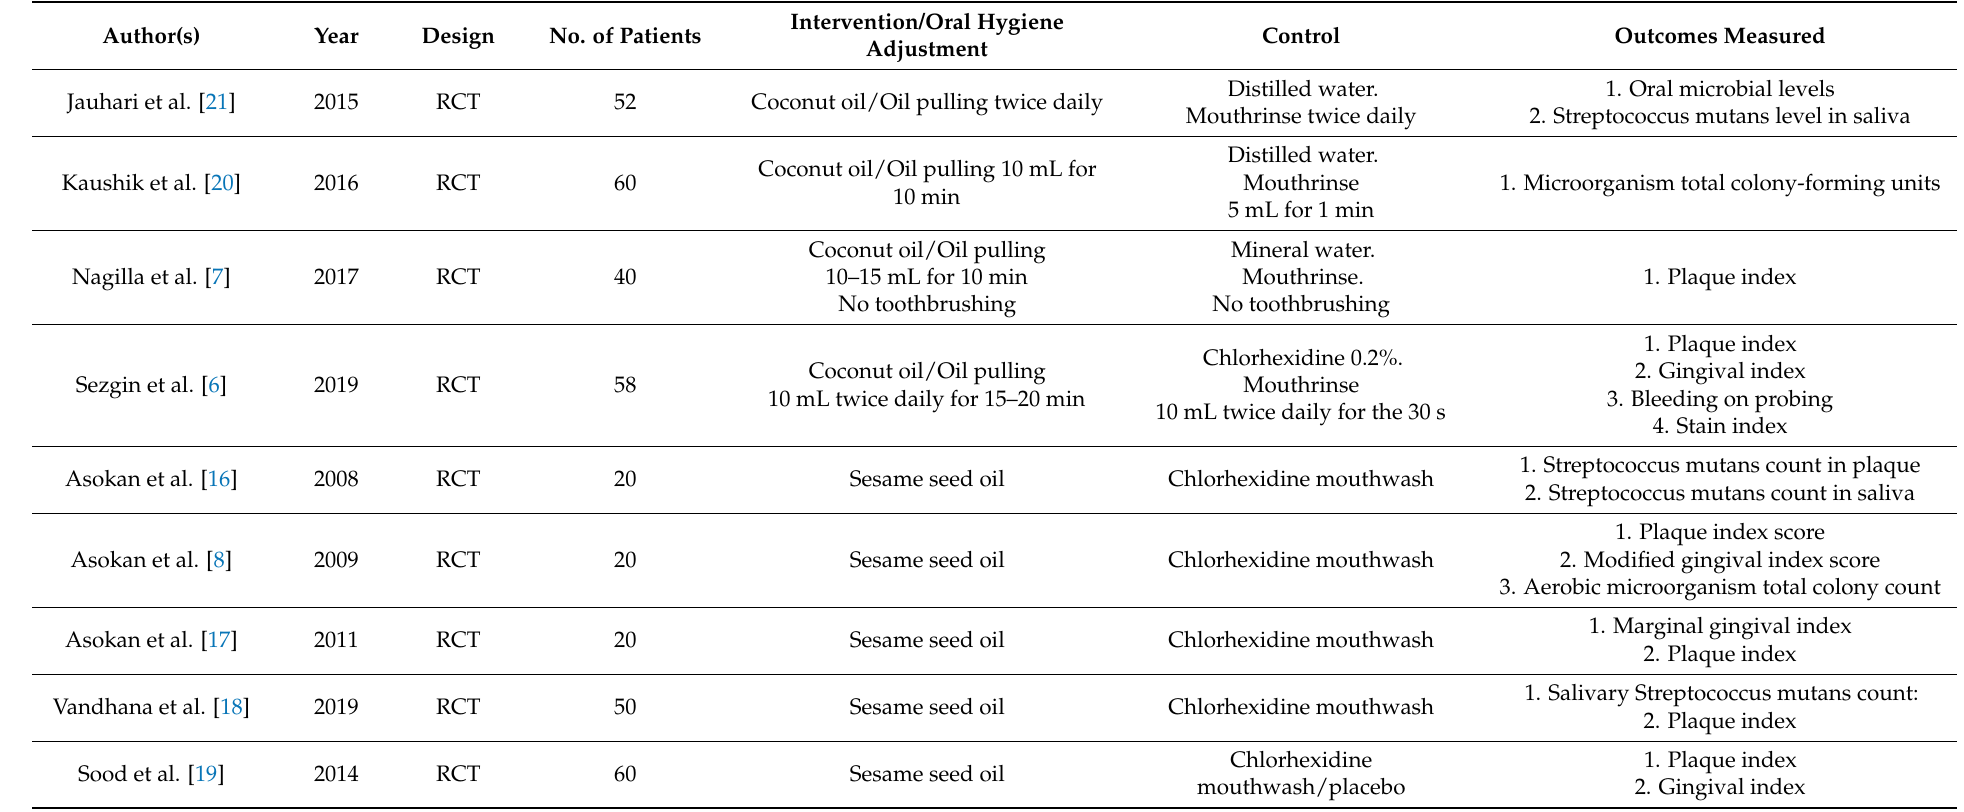
Table 1. The characteristics included RCTs examining the effect of oil